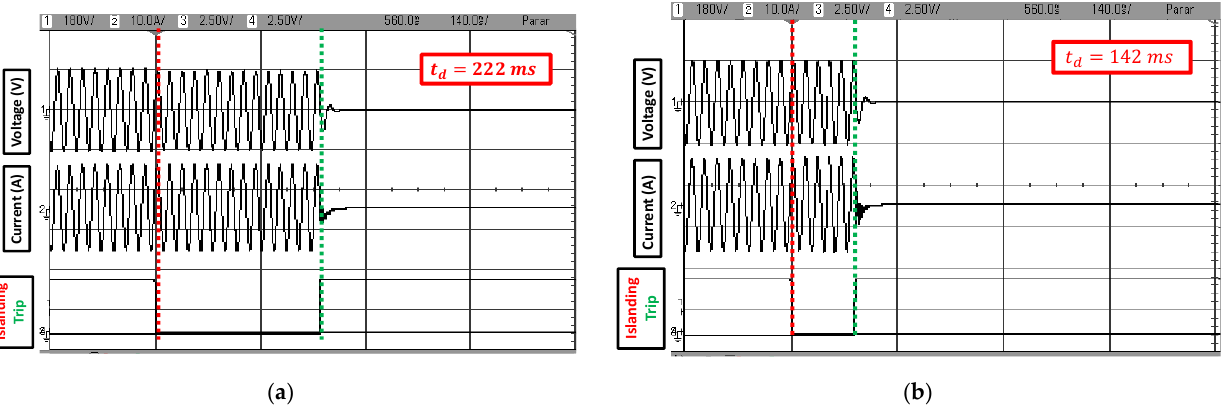
( b ) Figure 19. Inverter current ( a ) under AFD implementation; ( b ) under AFD by [24] implementation. 8.1. Experimental Results: Group I Figure 20a,b demonstrates, to the Classic AFD method and for the one proposed by [24], the experimental results of the PCC voltage, the Inverter current and the signals “Is- landing” and “Trip” that mark, respectively, the begging of the main grid interruption